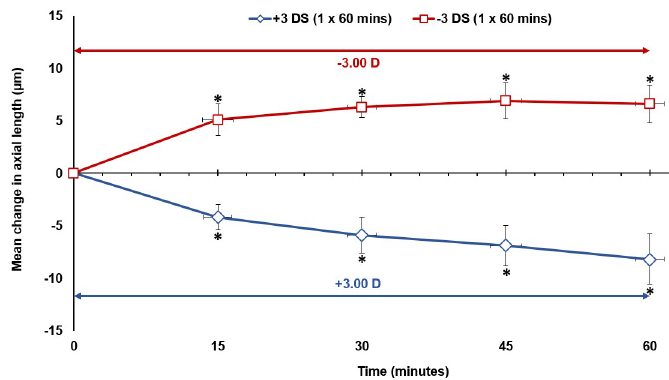
Fig 3. The mean change in axial length from baseline (0 minute time point), during 60 minutes of continuous hyperopic defocus (Condition A) and continuous myopic defocus (Condition B) for all subjects. Vertical error bars represent the standard error of the mean difference in axial length, and horizontal error bars represent the standard error in measurement time. Asterisks indicate a significant mean difference from baseline axial length (p <